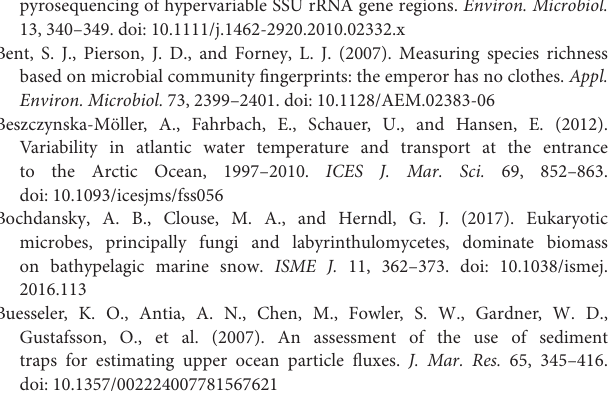
Supplementary Figure 1 | Alignment of a selected set of protist taxa. Restriction sites of HaeIII, Sau3aI, and the binding sites of the primer used in this study are